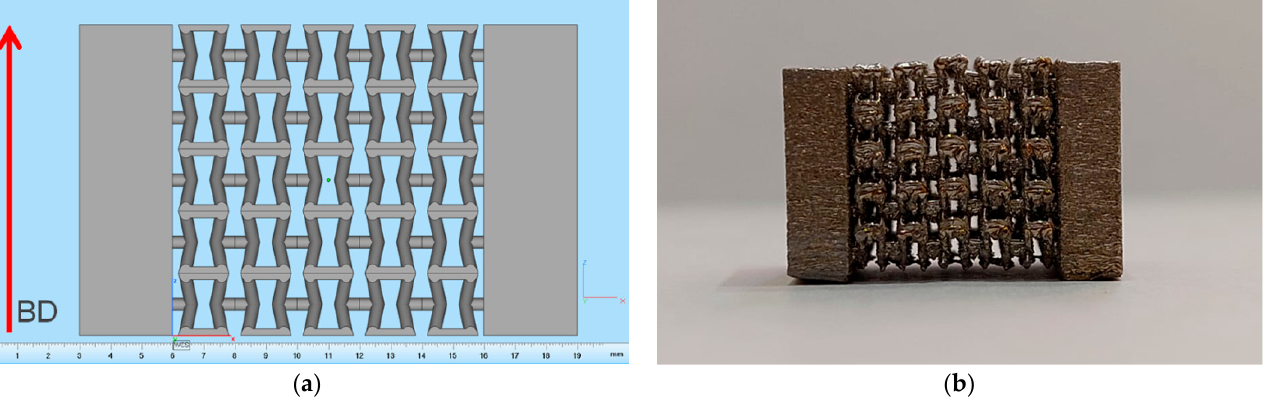
6 of 15 Figure 4. Maximum, reversible, and irreversible (residual) strain determined under the superelas ‐ ticity effect. 3. Results and Discussion 3.1. Results of Lattice Structures Simulation and Growth The mechanical characteristics given below were determined for the lattice structure